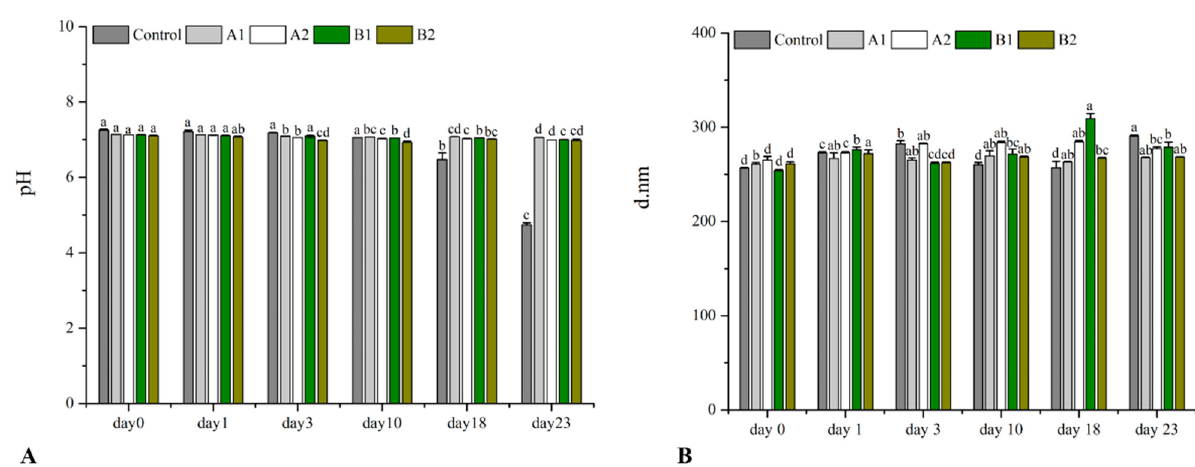
Figure 3. The effect on the O/W emulsion particle size and pH at different concentrations of ethanolic extract and newly identified compounds from the seed coat of Torreya grandis . ( A ) the initial pH, ( B ) the particle size of the emulsion, A1: 0.1 mg/mL TE; A2: 0.2 mg/mL TE; B1: 0.1 mg/mL F2; B1: 0.2 mg/mL F2. The same additive and the same concentration with different letters indicate a significant difference ( p < 0.05).